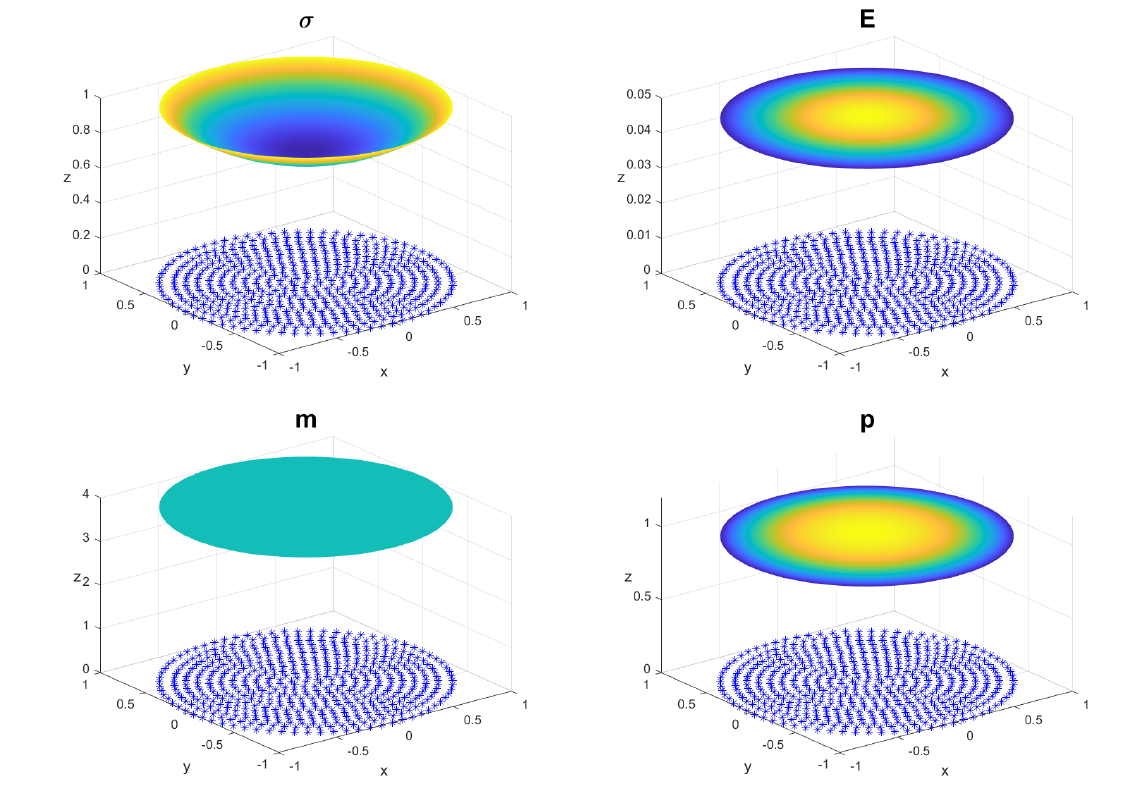
Figure 6. Graphs of the functions: σ , E , m and p for t = 5 s.